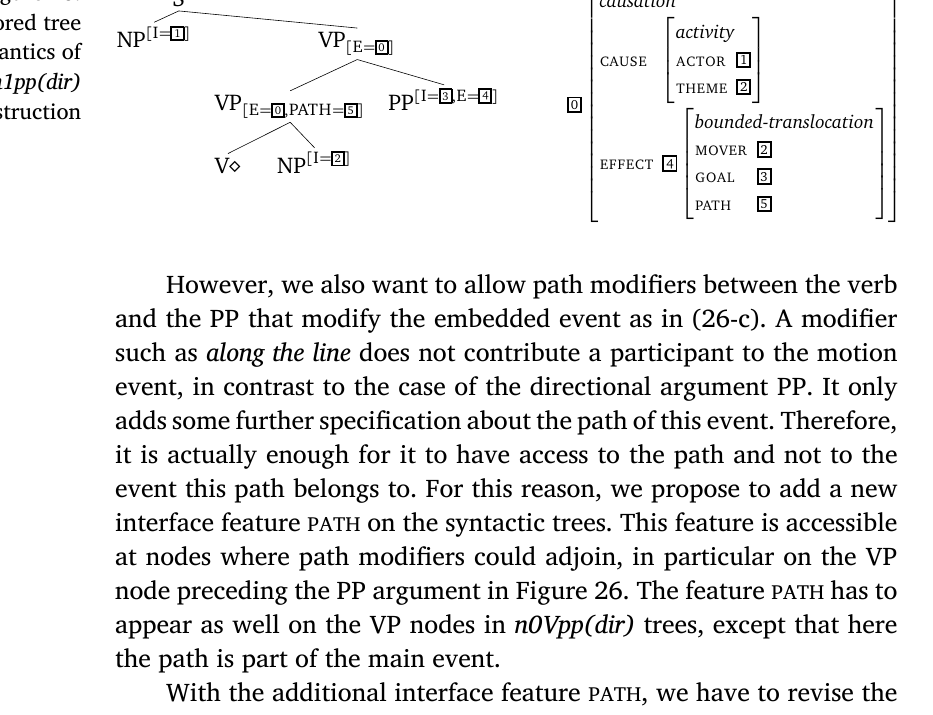
and semantics of n0Vn1pp(dir) construction